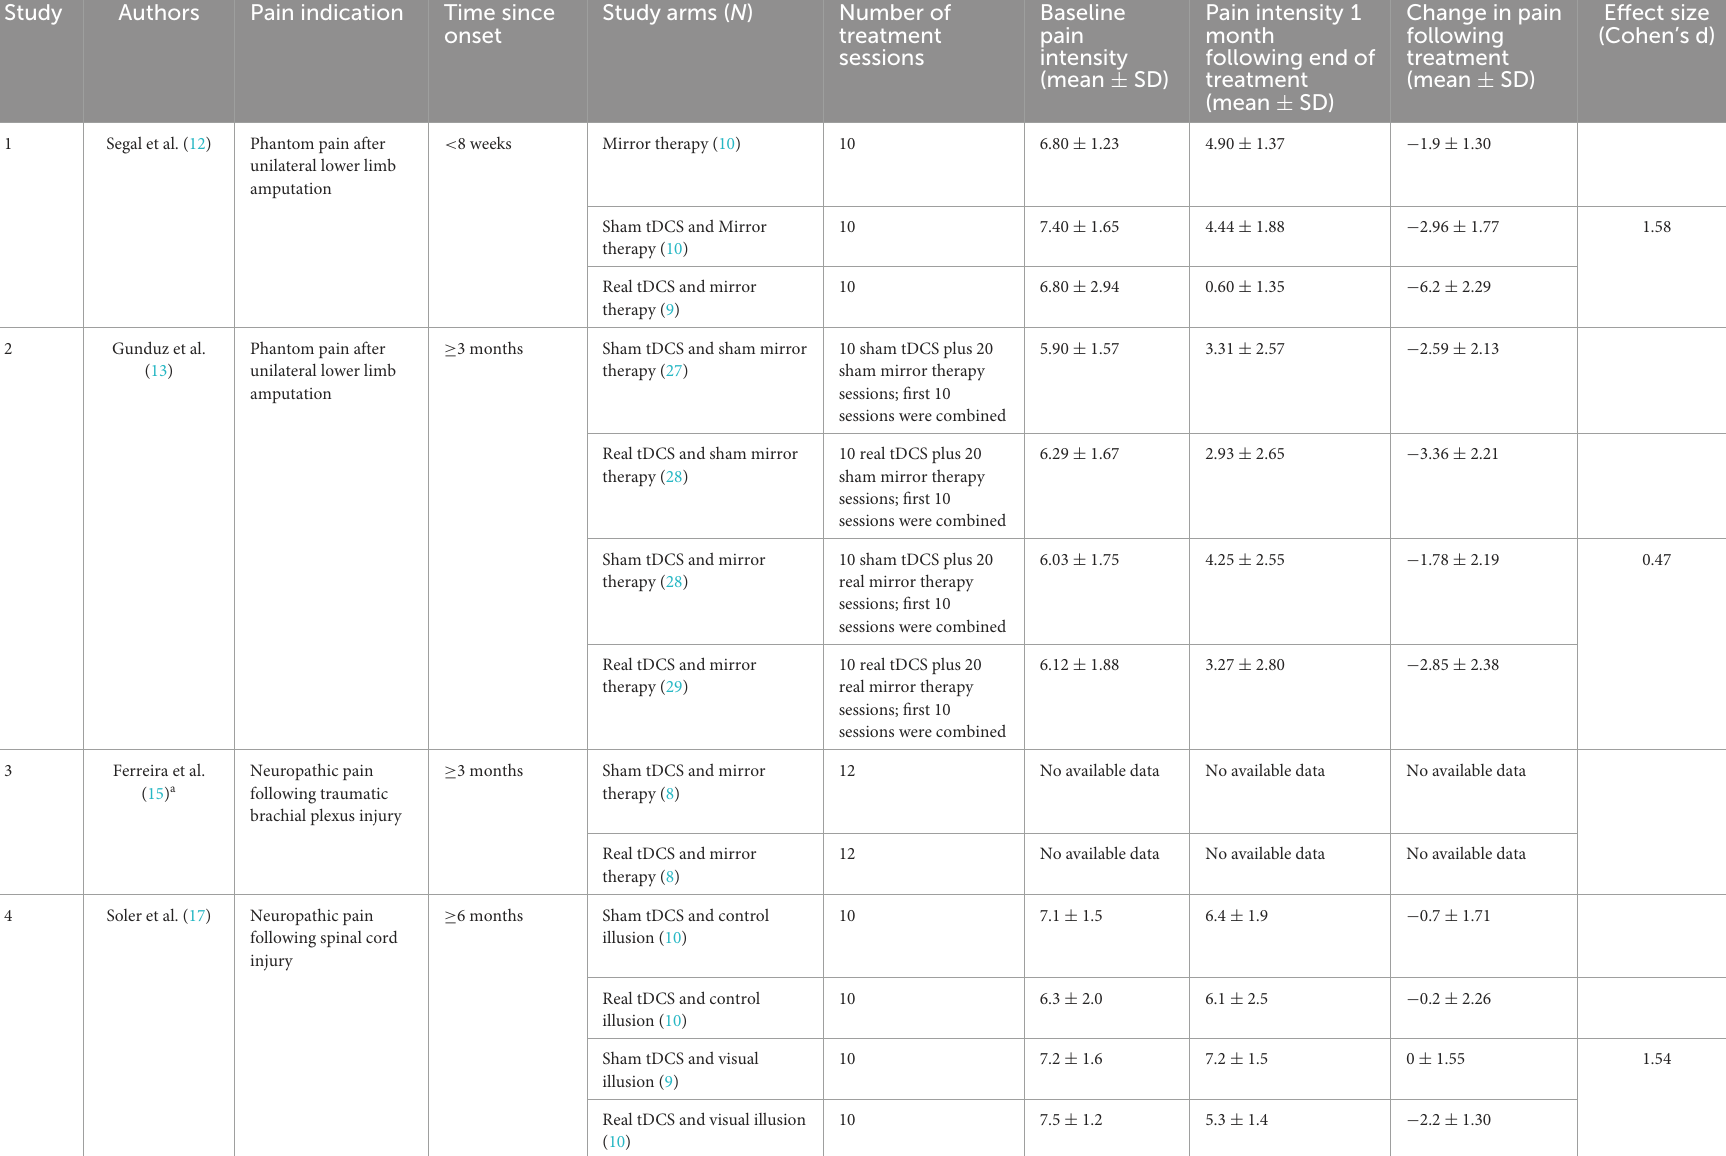
TABLE 2 Comparison of the analgesic effects among similar studies of tDCS combined with other therapies for pain.